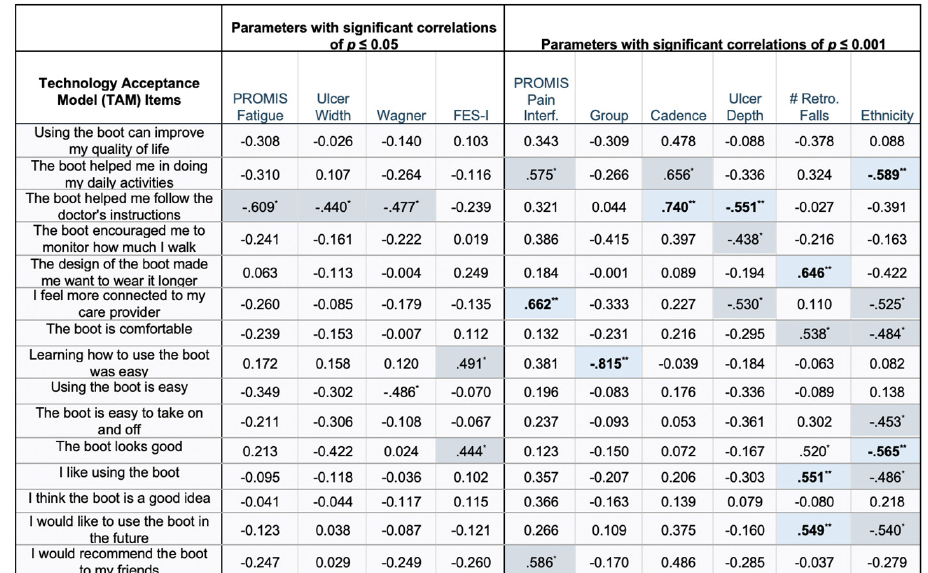
Figure 4. Significant Spearman correlations between participant ratings on Technology Acceptance Model (TAM) Questionnaire items and participant characteristics. Ratings were coded as 1= strongly agree, 2 = agree, 3 = neutral, 4 = disagree, and 5 = strongly disagree. Significance was considered p ≤ 0.05. p -values with asterisks (*) and dark blue shading denotes significance of p ≤ 0.05. Bold text with two asterisks (**) and light blue shading denotes significance of p ≤ 0.001, which are discussed in the main text. Non-significant correlations are listed in Supplementary Table S1. Abbreviations: MoCA = Montreal Cognitive Assessment, PROMIS = Patient-Reported Outcome Measurement Information System, FES-I = Falls Efficacy Scale International.